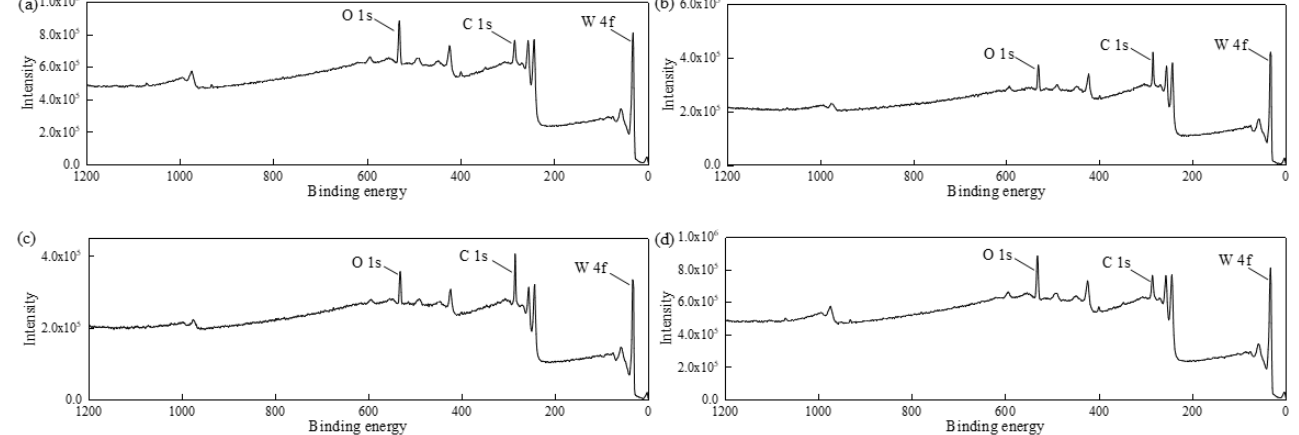
Figure 15. X ‐ ray photoelectron full spectra of the tungsten surface under different conditions: ( a ) pH 9 solution immersion; ( b ) H 2 O 2 solution immersion; ( c ) polishing slurry immersion; ( d ) after C ‐ SDP.